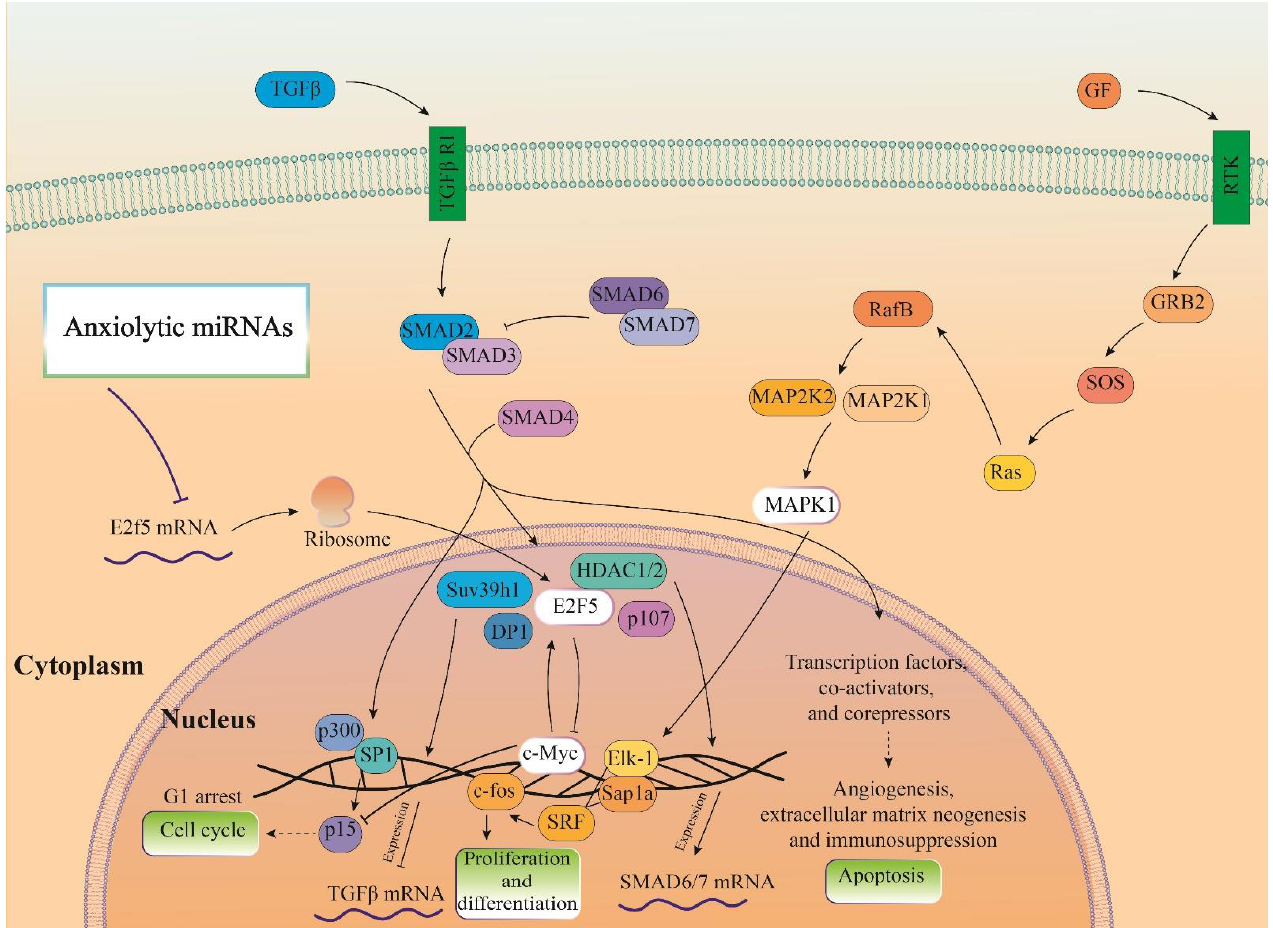
Figure 6. Illustration of the signaling pathways of the highlighted anxiolytic miRNAs (miR-34c, Let-7d, and miR-17). Gene was targeted by highlighted anxiolytic miRNAs (E2f5) that participate in TGF- β signaling and are also connected with MAPK and PI3K-Act signaling pathways via interaction with c-Myc.